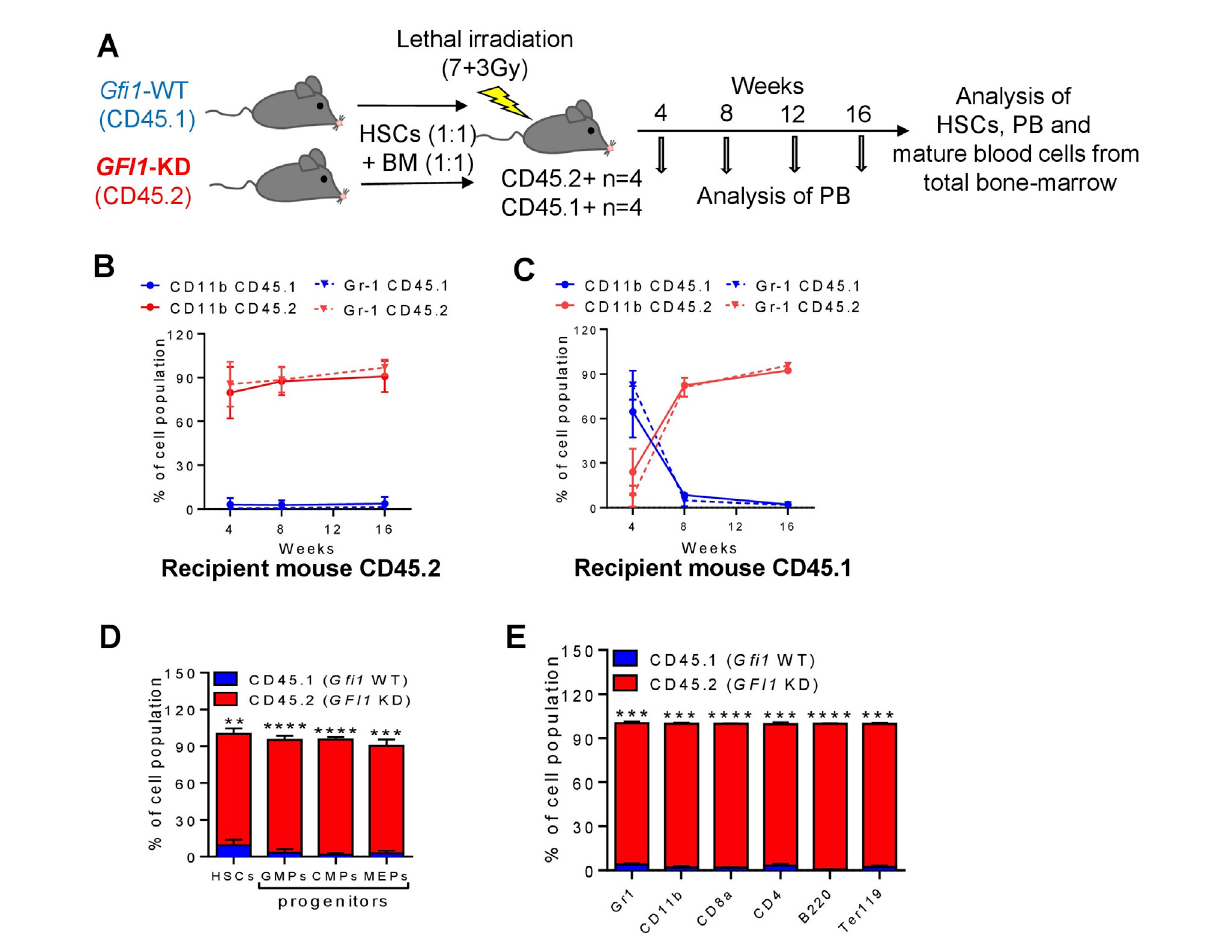
FIGURE 3 Mature cells were derived from CD45.2+ GFI1 -KD HSCs in a competitive transplantation setting with CD45.1+ G fi 1 -WT HSCs. (A) . Schematic representation of the competitive transplantation assay setup. HSCs were isolated from CD45.1 expressed G fi 1 -WT mice and CD45.2-expressing GFI1 - KD mice and were mixed in equal numbers (200 HSCs from each mouse) and transplanted into lethally irradiated C57Bl/6 recipient mice using 500,000totalBMcellsascarriercells(250,000fromeachmouse).Afterthetransplantation,thePBwasanalyzedatdifferenttimepointsandtheBM was analyzed upon euthanization for the presence of HSCs and mature blood cells. (B, C) . CD45.1 and CD45.2 expression on the cell surface of myeloid (granulocytes and monocytes) cells in the peripheral (PB) were measured by fl ow cytometry at 4, 8, 12, and 16 weeks after transplantation into